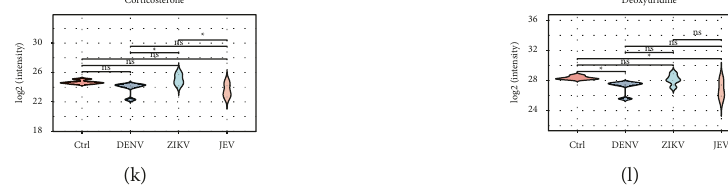
Figure 4: Urinary metabolite profiles reflect the characteristics of flavivirus infections. PCA in (a) the positive-ion mode and (b) the negative-ion mode. PLS regression in (c) the positive-ion mode and (d) the negative-ion mode. (e) Metabolite cluster heatmap of urine. (f), (g) Metabolomic view of pathway analysis to show the most obvious metabolic pathways affected by flavivirus infection. (h–l) Violin plots of metabolites used to differentiate ZIKV infection from controls. (h) Arachidonic acid, (i) guanosine, (j) 9,10-epoxyoctadecenoic acid, (k) corticosterone, and (l)